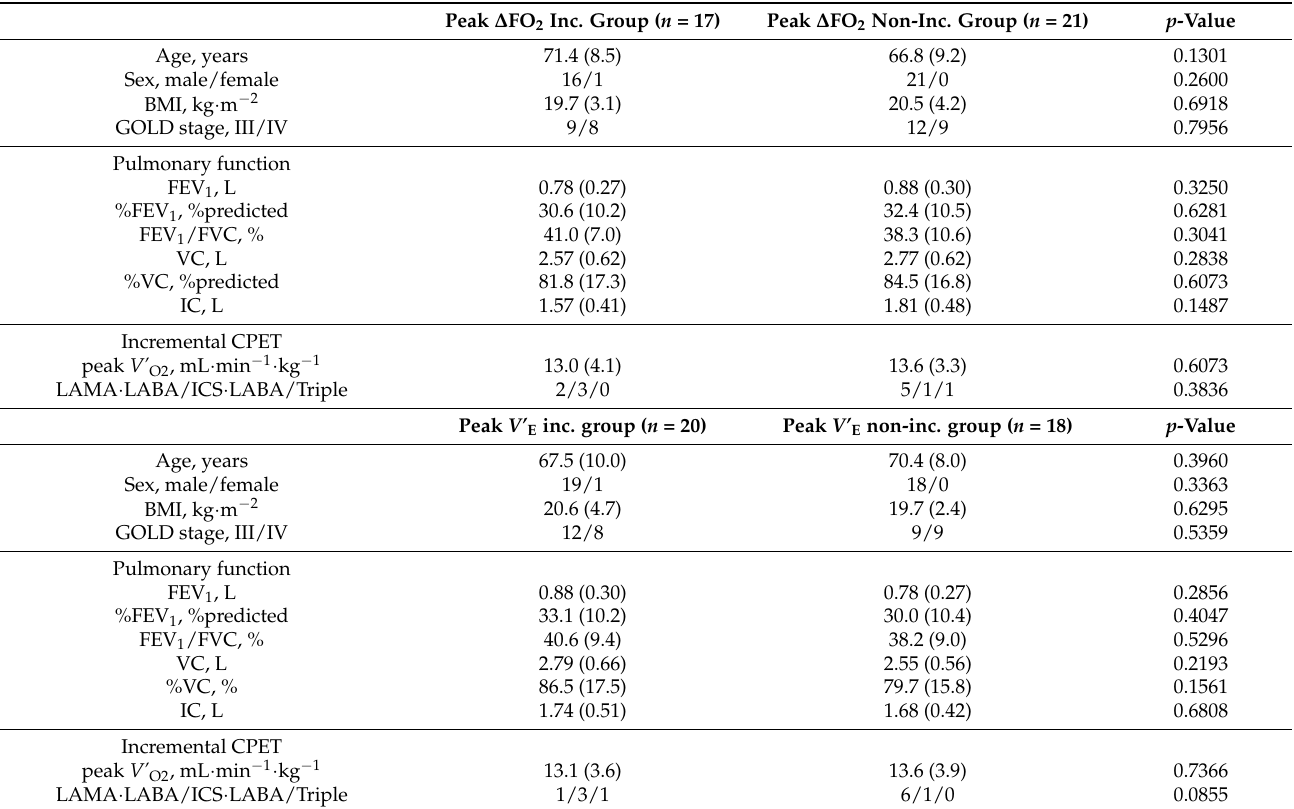
Table 3. Comparison between groups stratified according to the change in peak ∆ FO 2 or peak V’ E ( n = 38) after pulmonary